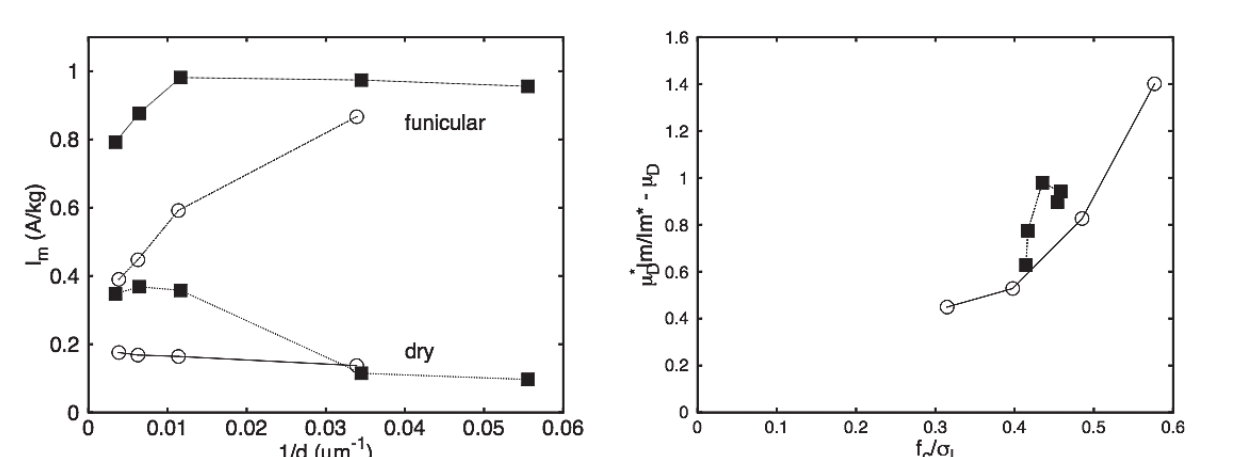
Fig. 7 Left: specific intensity at dry or funicular state versus the inverse of the mean diameter. Right: scaled specific intensity at funicular state (Eq. 6) versus the inverse of the one-point Flow Function. Squares: calcites, circles: glass